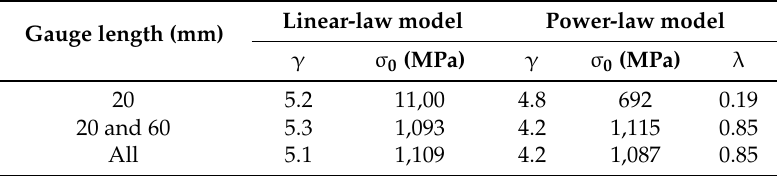
Table 2. Weibull statistics for bamboo fiber strength.